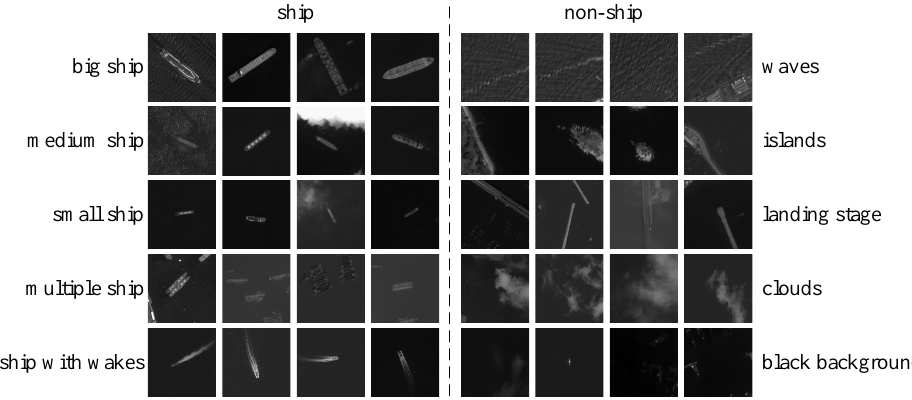
Figure 8. Some typical instances of ship targets ( left ) and non-ship targets ( right ) in our 10 class